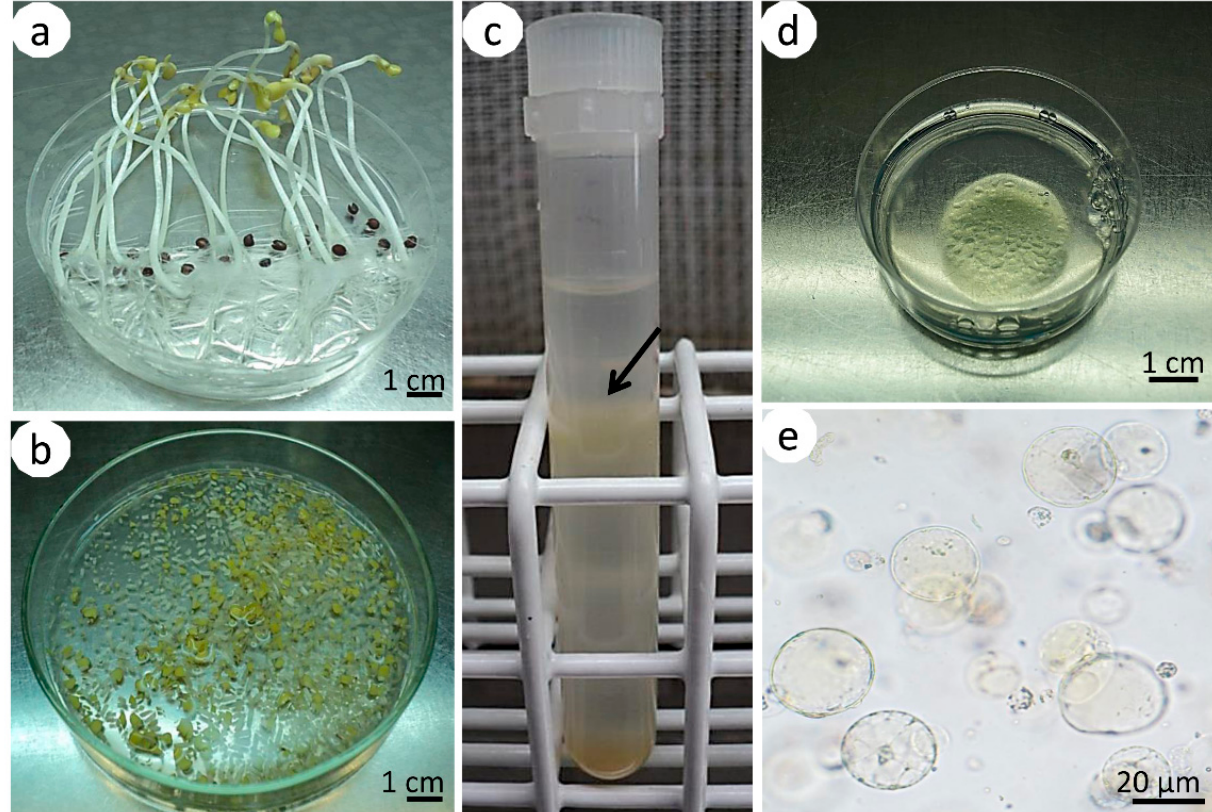
Figure 1. Isolation and immobilization of hypocotyl-derived protoplasts of Brassica oleracea L. var. capitata. Two-week-old, etiolated seedlings with elongated hypocotyls ( a ); fragmented hypocotyls subjected to plasmolysis ( b ); test tube with hypocotyl protoplasts gathered in a ring (arrow) between solutions of sucrose/2-(N-morpholino) ethanesulfonic acid (sucrose/MES) and W5 ( c ); Petri dish with an alginate layer with immobilized protoplasts ( d ); microscopic view of spherical protoplasts immobilized in an alginate layer ( e